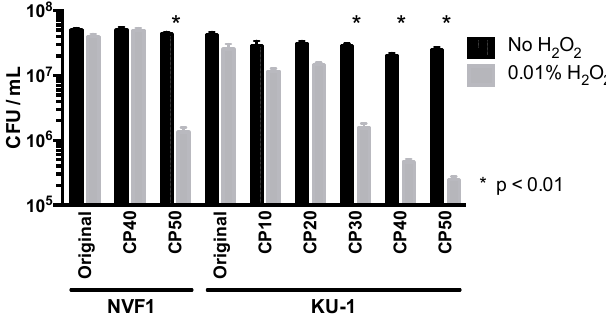
Figure 8. Survival of the passaged variants after exposure to H 2 O 2 . CDM-passaged variants were diluted to approximately 10 7 colony-forming unit / mL in PBS and thereafter exposed to 0.01% of H 2 O 2 for 4 h. CFUs are shown as mean + SEM (error bars) based on a minimum of three triplicate observations representing the three independent experiments shown. *, p -value less than 0.01 was considered statistically significant. KU-1 variants passaged on Chamberlain’s chemically defined medium-based agar (CDMA) 30 times (CP30), 40 times (CP40), and 50 times (CP50), and NVF1 CP50 were significantly susceptible to H 2 O 2 while KU-1 variants passaged on CDMA 10 times (CP10), 20 times (CP20), and NVF1 CP40 were not